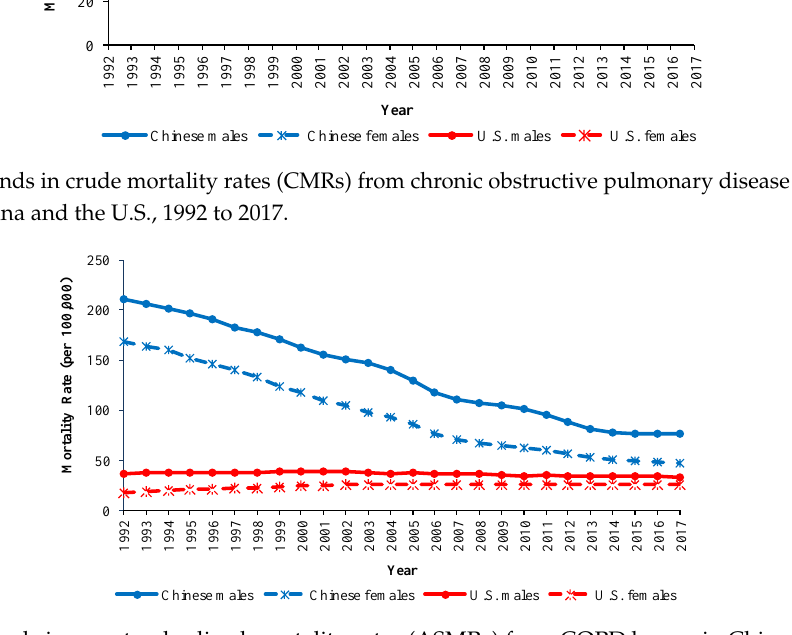
Figure 2. Trends in age-standardized mortality rates (ASMRs) from COPD by sex in China and the U.S., 1992 to 2017.